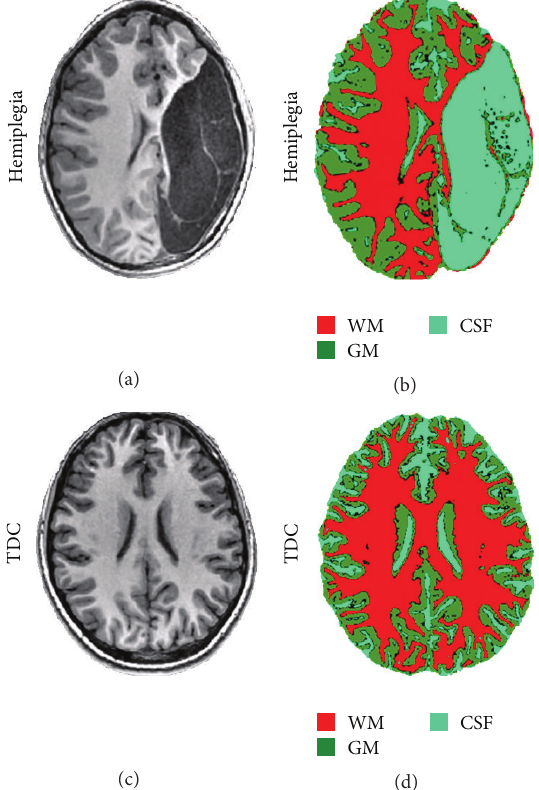
Figure 2: Representative data demonstrating brain anatomy images and cerebral tissue segmentation results obtained from a 7-year-old child with hemiplegia (a-b) and from a healthy age-matched control (c-d); the three obtained clusters were identified as white matter (WM), gray matter (GM), and cerebrospinal fluid (CSF). Note the increased cortical thickness in the hemisphere contralateral to the lesion of the children with hemiplegia (b) compared to TDC